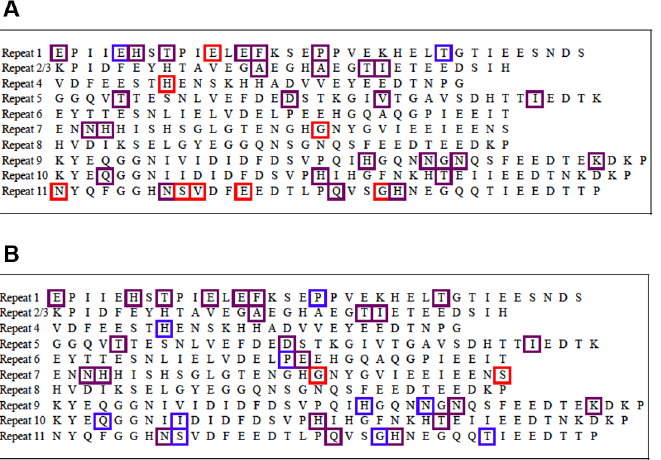
boxes indicate SNPs that were only present in isolates from the prosthetic joint infection group (PJI), blue boxes indicate SNPs that were only present in the uninfected (PJU) group, and purple boxes indicate SNPs that were present in both PJI and PJU isolates.